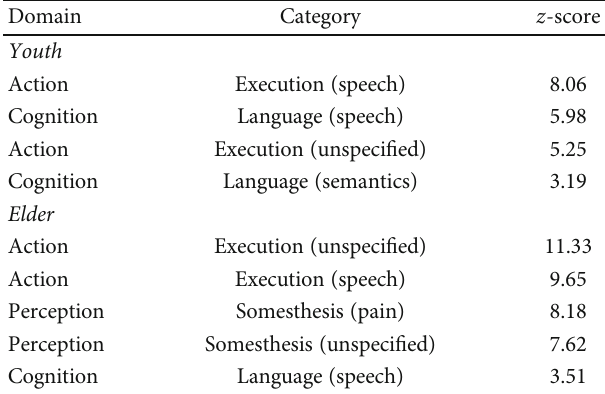
Table 3: Positive associations of behavioral domain data from MANGO for regions of ReHo clusters ∗